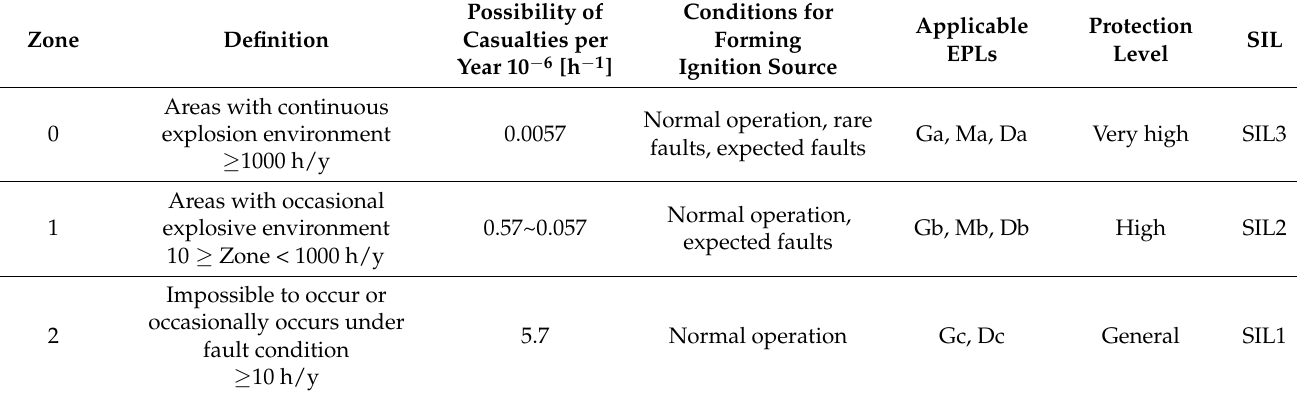
Table 10. Relationship among EPL, fatalities per year and SIL